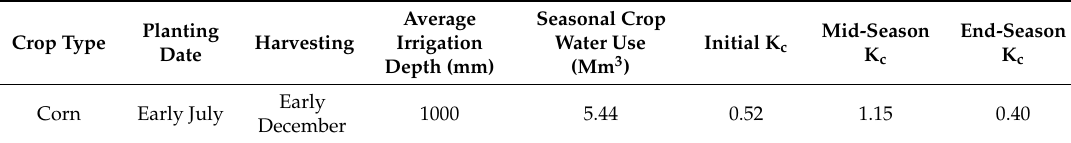
Table 1. Characteristic of the cultivated